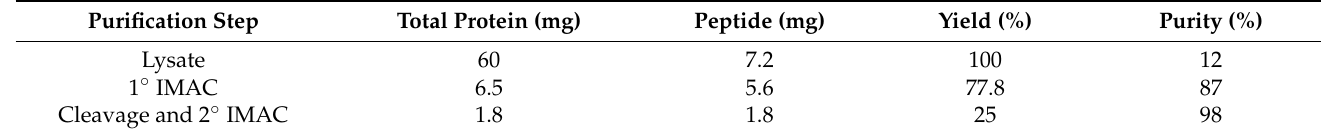
Figure 4. MALDI-TOF MS spectrum of the rBmK-AGAP peptide. After the second purification step, the peptide was analyzed with the VITEK MS (BIOMERIEUX) mass spectrometer using α -Cyano- 4-hydroxycinnamic acid as the matrix. The 7533 peak coincided with rBmK-AGAP, while the 10,612 value corresponded to free SmbP present in the sample. Table 1. Purification summary of rBmK-AGAP. Table 1. Purification summary of rBmK-AGAP.